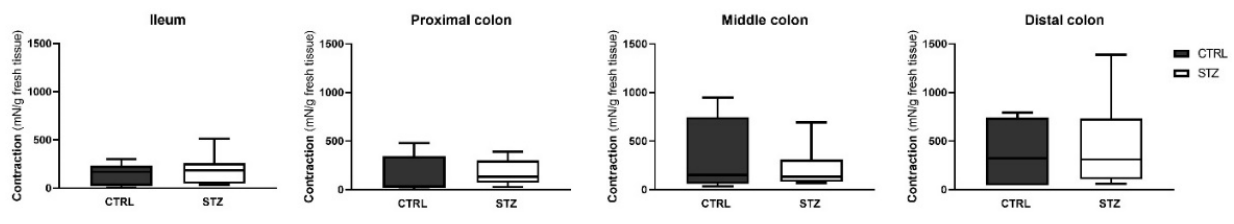
Figure 5. Contractile response to KCl (125 mM) in the ileum, proximal colon, middle colon and distal colon of control (CTRL, n = 6) and streptozotocin-induced diabetic rats (STZ, n = 10). Data are expressed as mN of force per g of fresh tissue (mN/g). Values represent the median (95% confidence limits) and a Mann–Whitney test was used to compare the two experimental groups (CTRL and STZ).